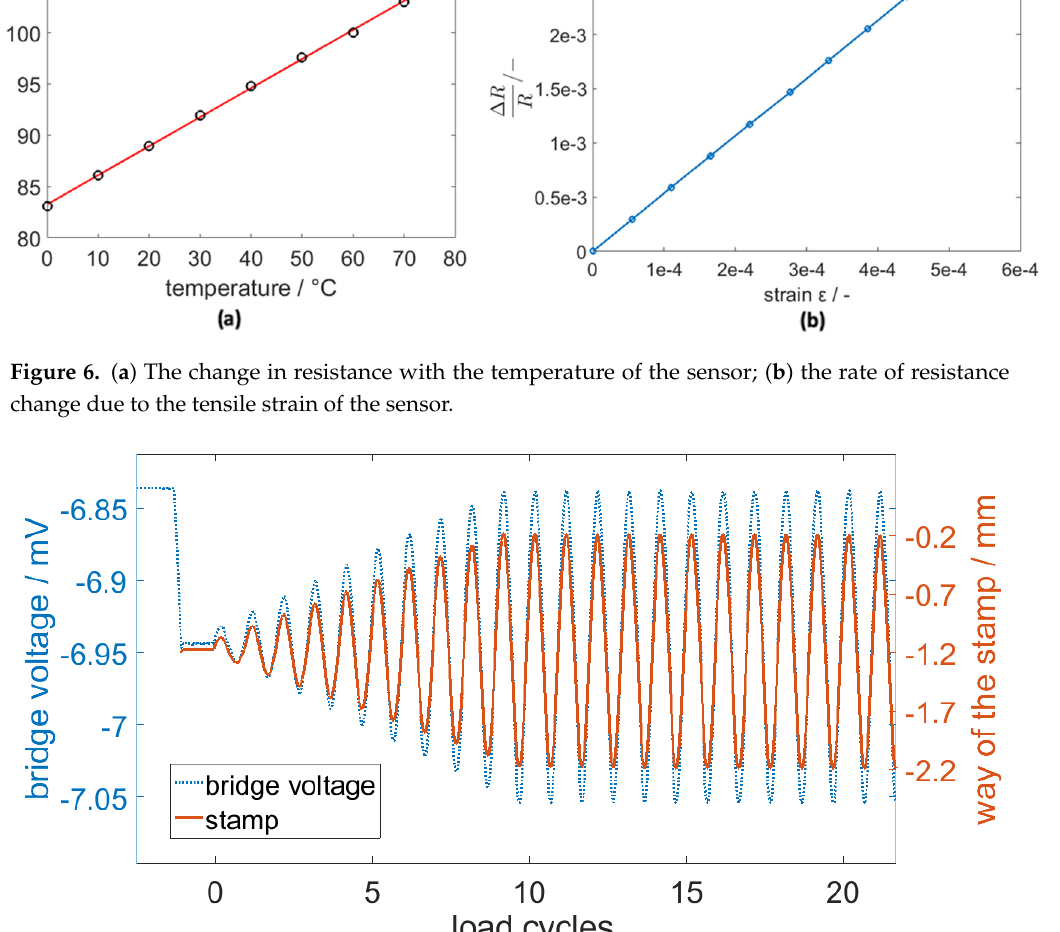
Figure 6. ( a ) The change in resistance with the temperature of the sensor; ( b ) the rate of resistance change due to the tensile strain of the sensor.